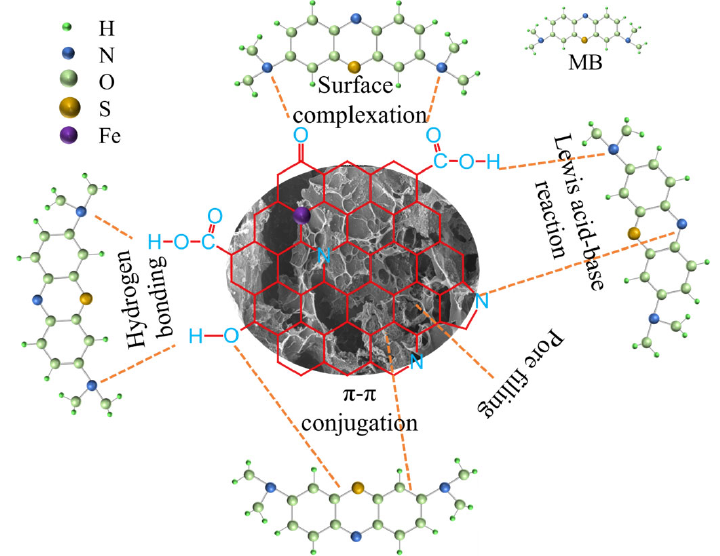
Figure 10. Illustration of adsorption modality between the BAC and